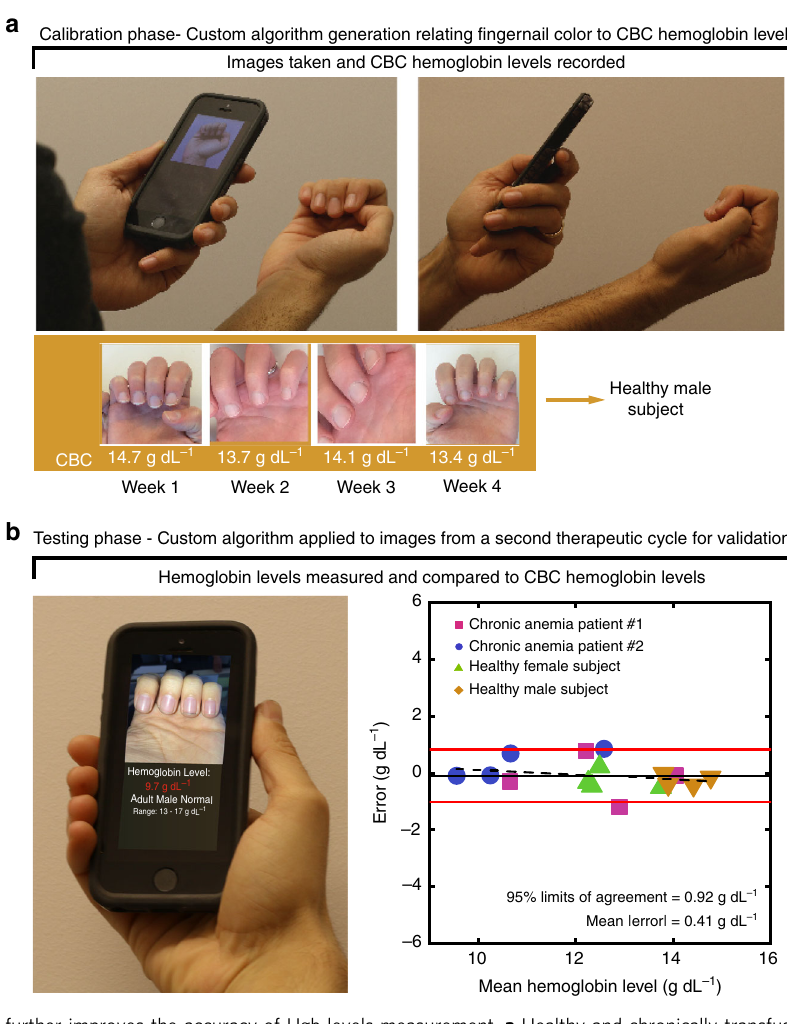
Fig. 4 Personalized calibration further improves the accuracy of Hgb levels measurement. a Healthy and chronically transfused anemic patients were monitored over four weeks (i.e., over the course of a therapeutic blood transfusion cycle). CBC Hgb levels (white text) were used in conjunction with the images to generate a personalized algorithm for each individual. b The patient-speci fi c algorithms were used to measure Hgb levels over a subsequent blood transfusion cycle. This patient-speci fi c calibration improved the average error of Hgb level measurements to within 0.41 g dL − 1 of the CBC Hgb level. Bland – Altman analysis shows negligible experimental bias in the data. A random effects model is used to statistically con fi rm consistency of average Hgb level measurement error between individual subjects. The average error (solid black line) indicates the Hgb measurement of the smartphone app is negligibly biased. The dashed line represents the correlation ( r = − 0.24) between the residual error and the average of Hgb level measurements obtained from the CBC and the algorithm. The solid red lines represent 95% limits of agreement (0.92 g dL − 1 ). n = 4 patients, 4 measurements per